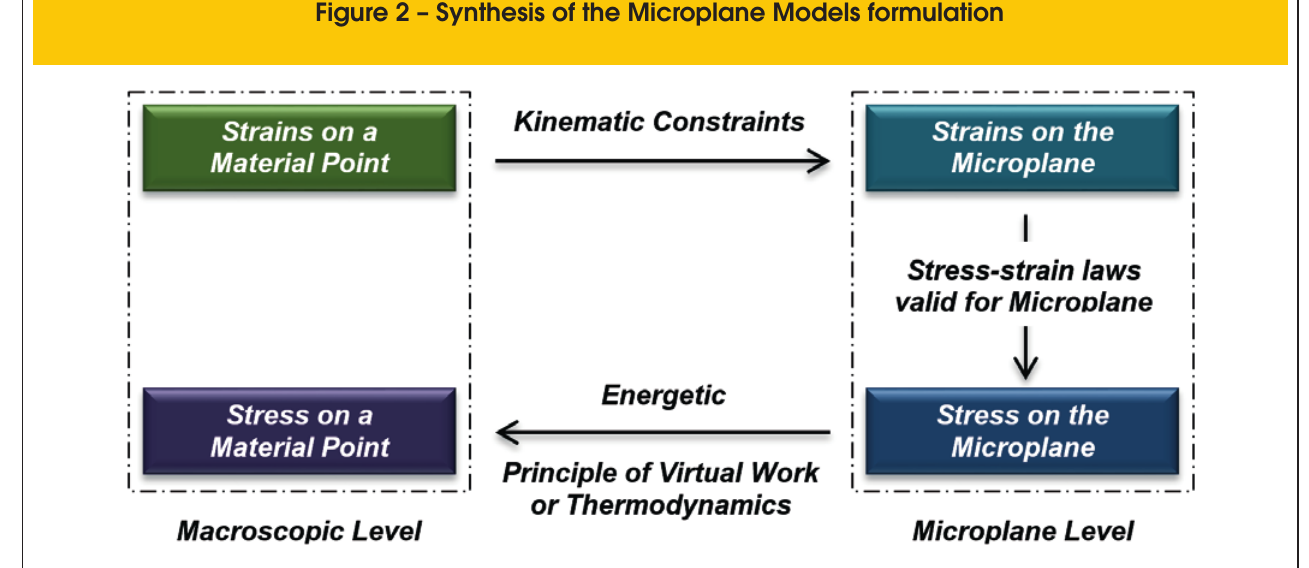
Figure 2 – Synthesis of the Microplane Models formulation